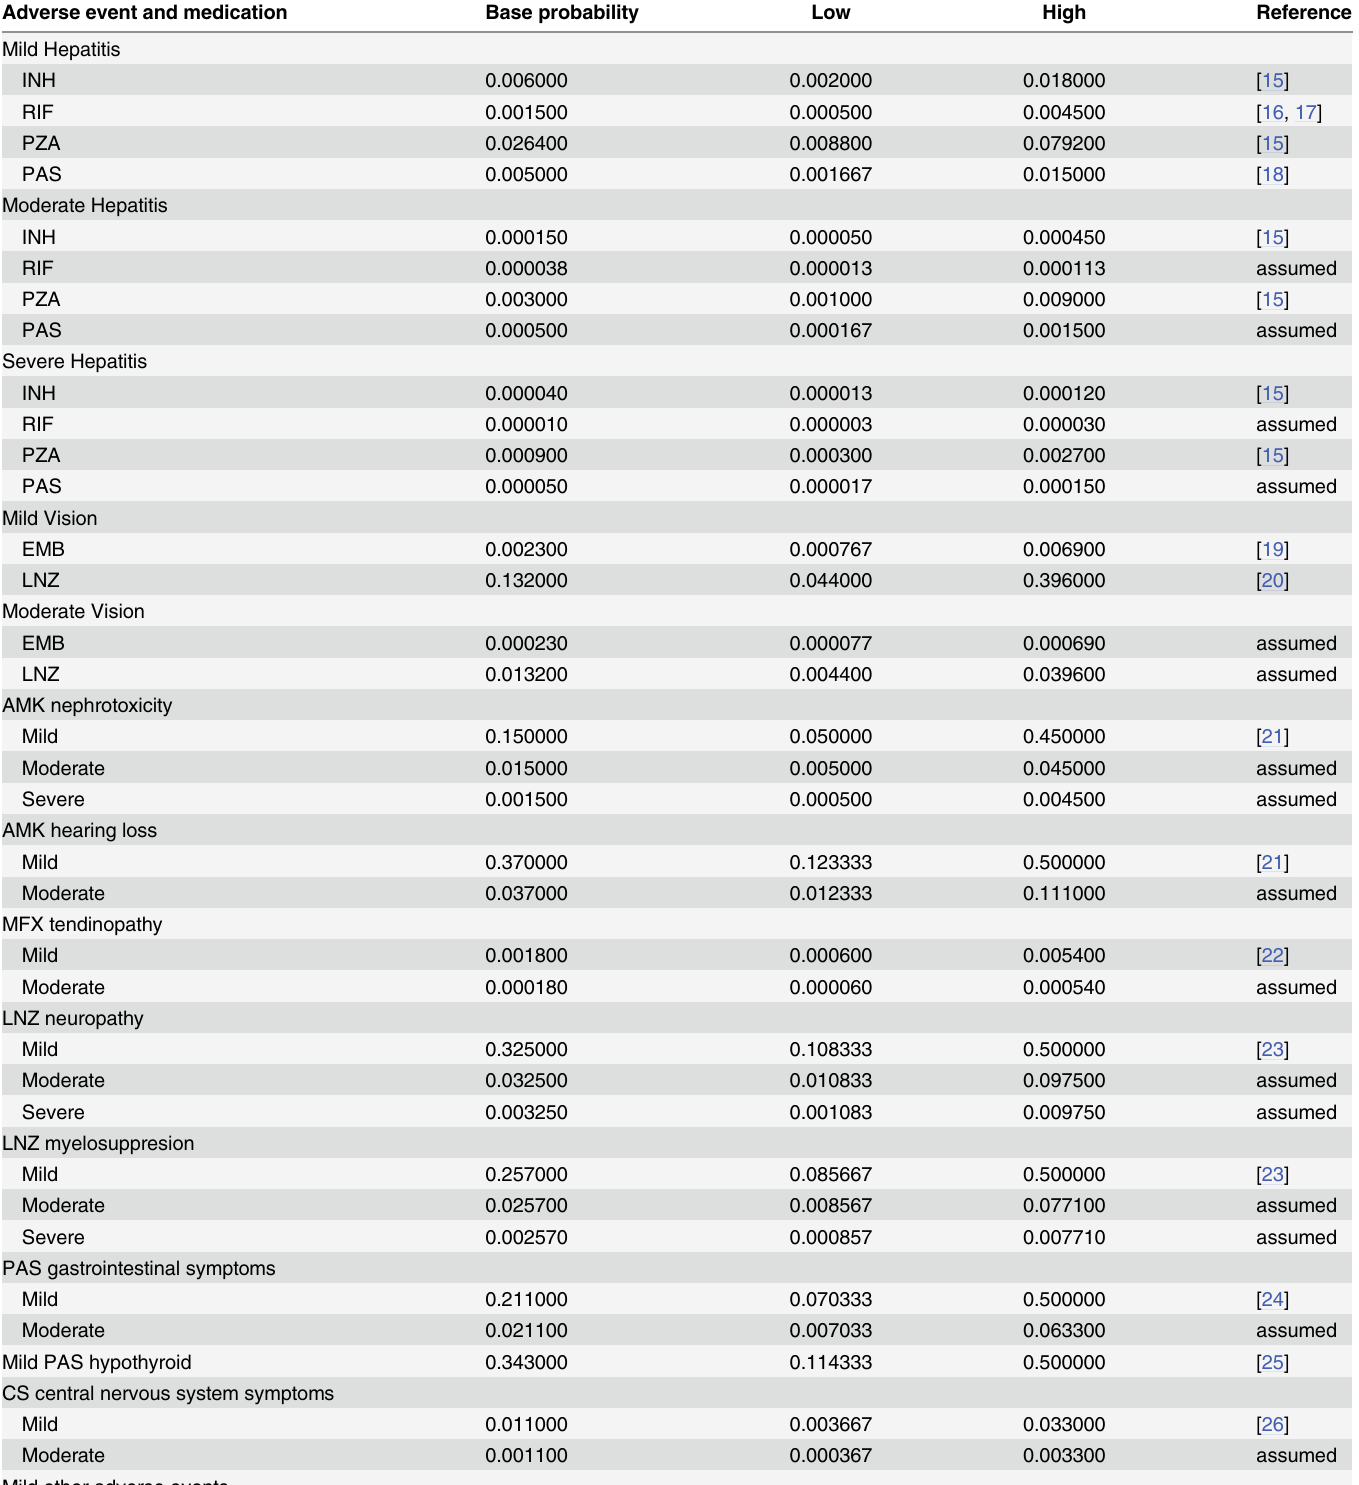
Table 2. Probability and ranges of a medication adverse event. a,